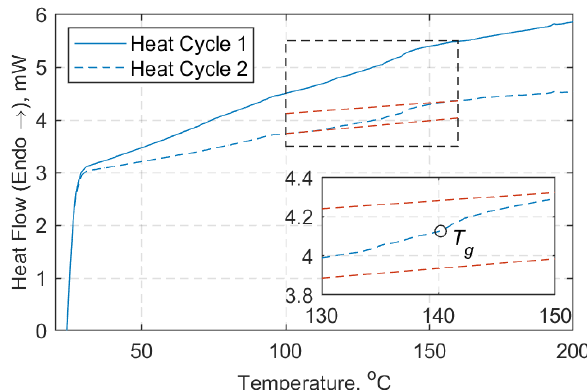
Table 3. DSC and DMTA results: Glass transition temperature ( T g ).